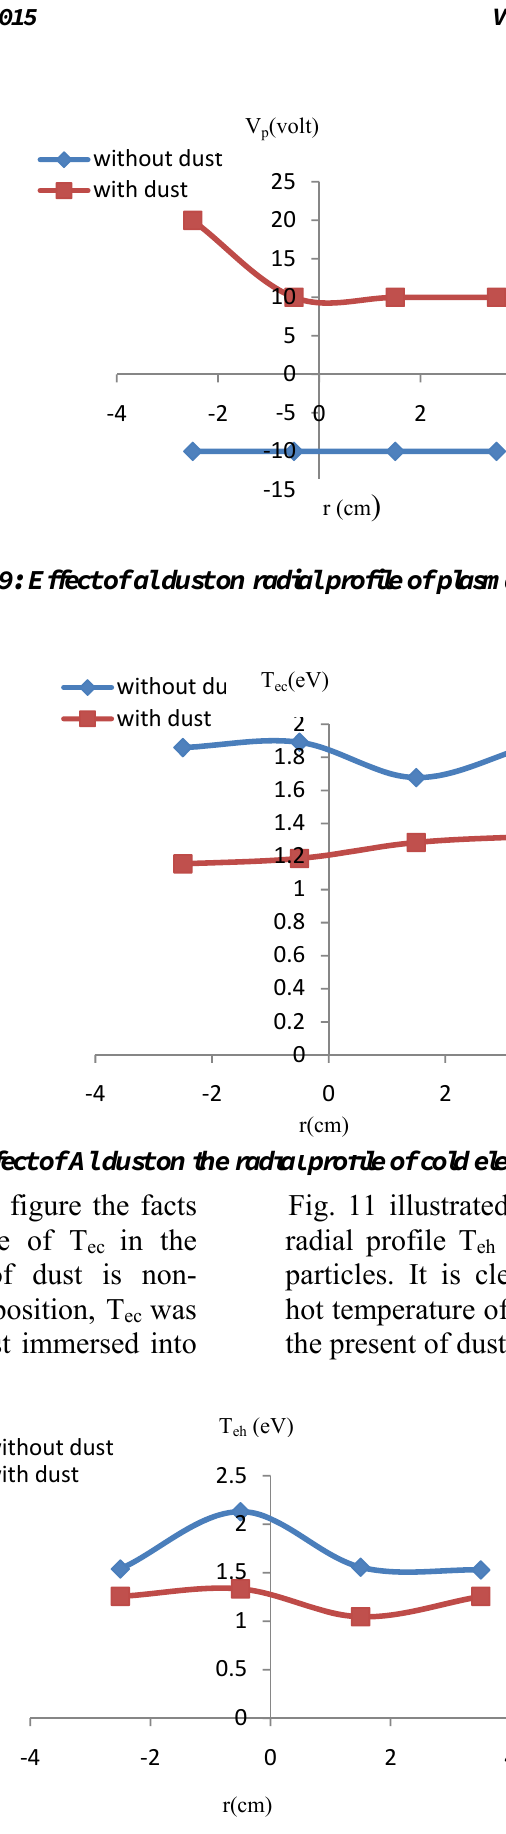
Fig.11: Influence of Al dust on the radial distribution of hot electron temperature.